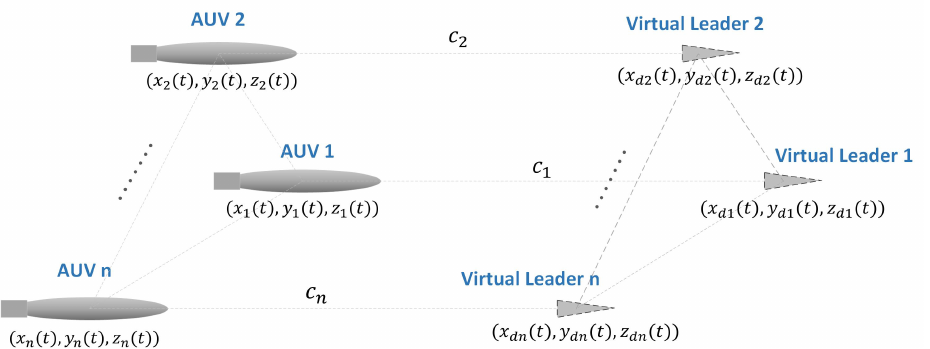
Figure 2. Virtual structure based multiple AUVs